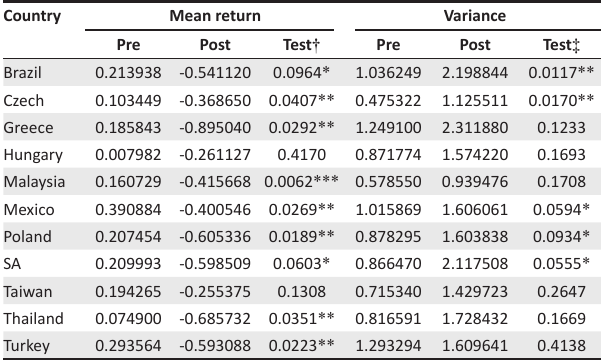
TABLE 3: Results of equality tests. Country